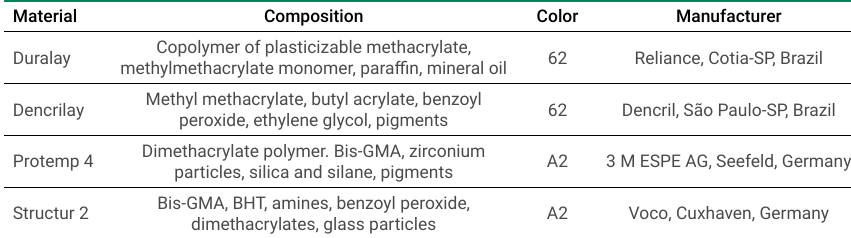
Table 1. Provisional prosthetic materials used in the study. Material Composition